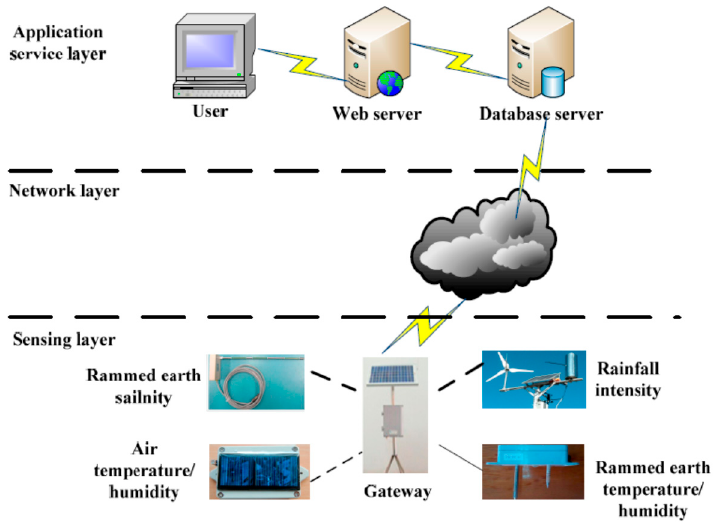
Figure 7. The IoT based sensing infrastructure for Ming Dynasty Great Wall.